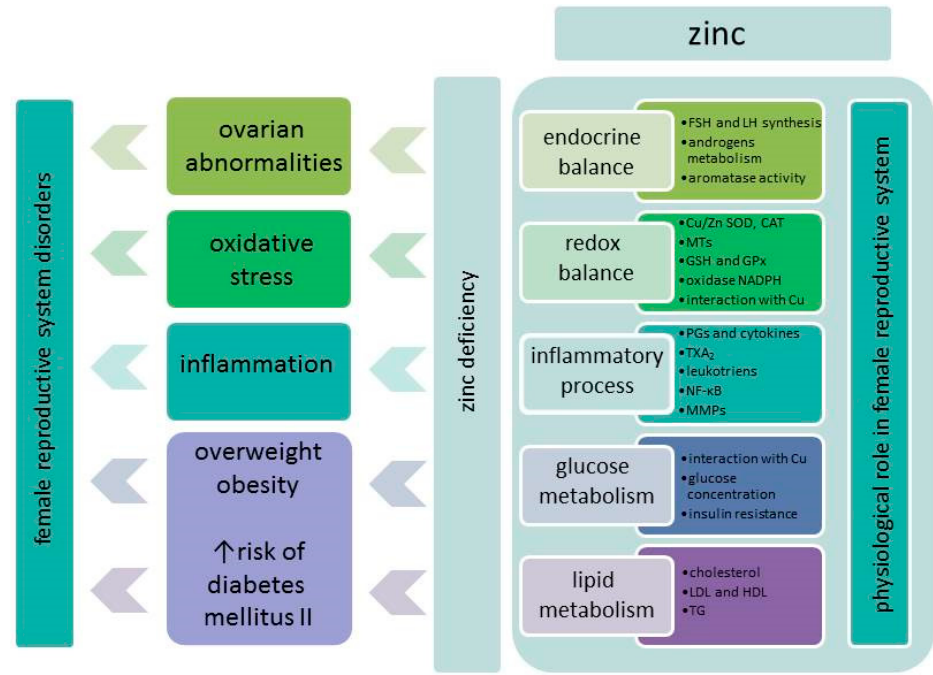
Figure 1. Involvement of zinc in female reproductive system according to [19,25–31]. Abbreviations: CAT: catalase; Cu / Zn SOD: Cu / Zn superoxide dismutase; FSH: follicle stimulating hormone; GPx: glutathione peroxidase; GSH: glutathione; HDL: high density lipoprotein; LDL: low density lipoprotein; LH: luteinizing hormone; MMPs: matrix metalloproteinases; MTs: metallothioneines; NF- κ B: nuclear factor κ B; PGs: prostaglandins; TG: triglycerides; TXA 2 : thromboxane A 2 .